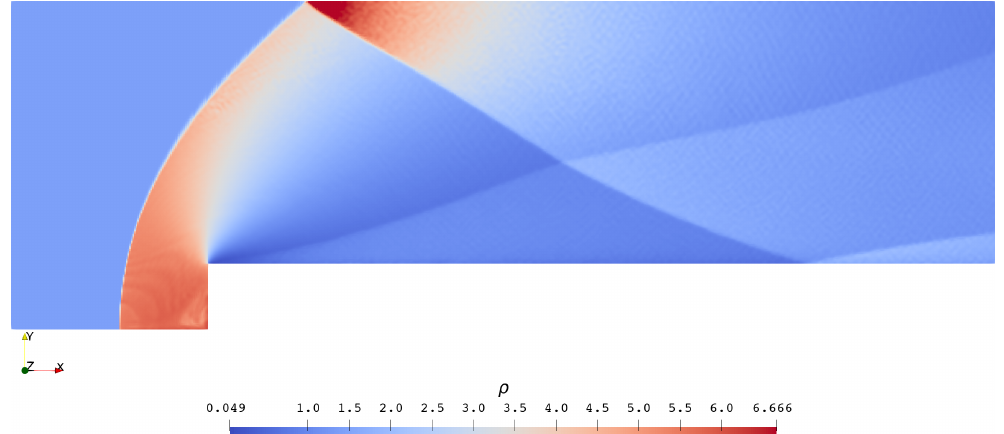
Figure 14. Third-order solution of Problem 4 at t = 1.2 on an h = 1/200